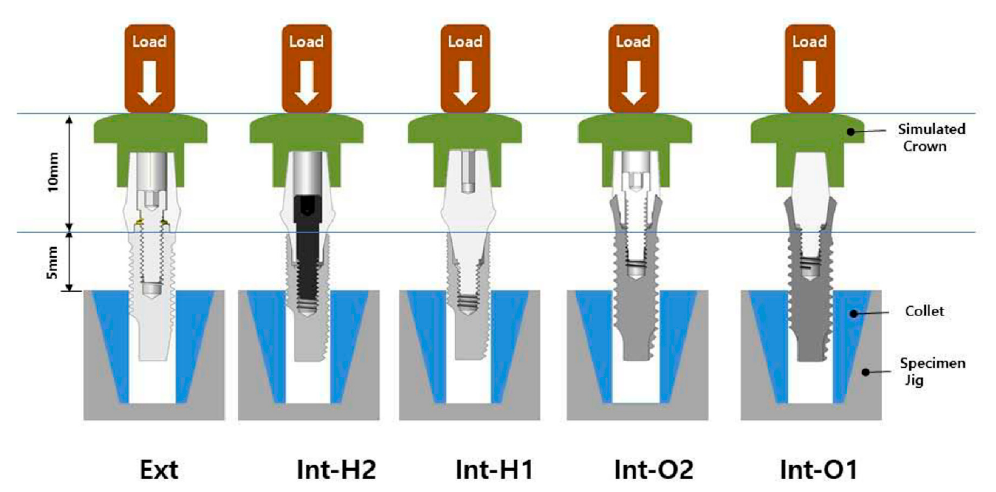
Figure 1. Schematic drawing of the test setup. Ext: external hexagon fixture + Cemented abutment; Int-H2: internal hexagon fixture + two-piece abutment; Int-H1: internal hexagon fixture + one-piece abutment; Int-O2: internal octagon fixture + two-piece abutment; Int-O1: internal octagon fixture + one-piece abutment.